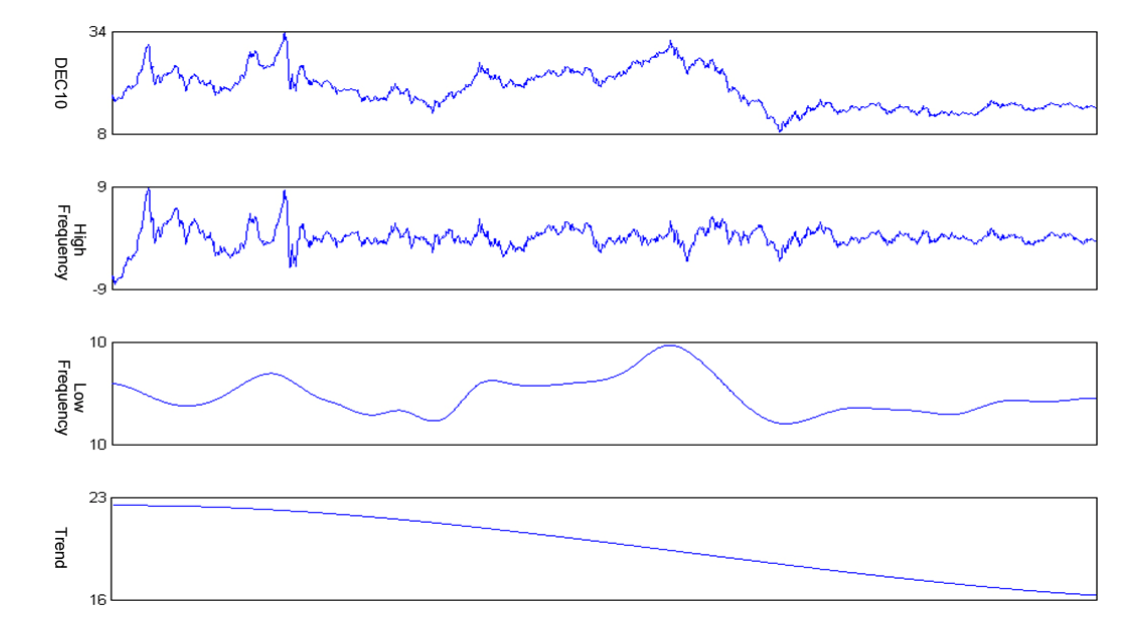
Table 2. Mean of